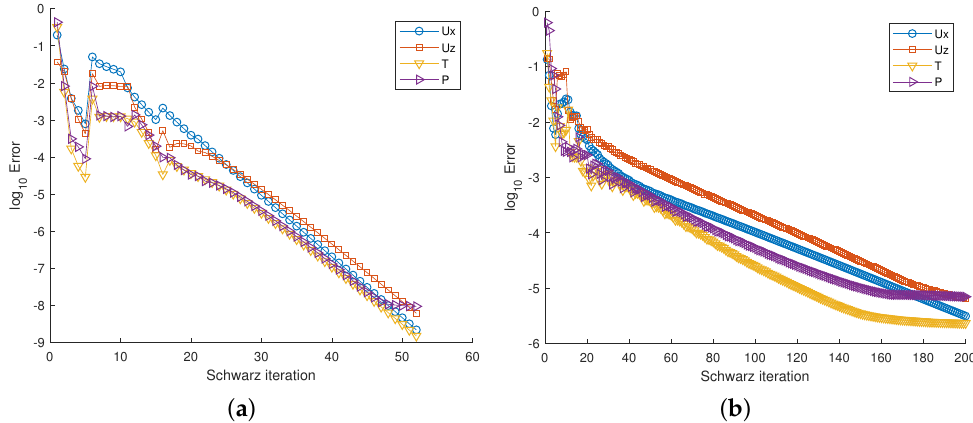
Figure 11. Graph of the log 10 of the errors in the velocity, temperature, and pressure fields for the Schwarz iterations: ( a ) R = 1300, Γ = 3.495, np = 2, mp = 1, N × M = 10 × 10; ( b ) R = 5000, Γ = 3.495, np = 8, mp = 2, N × M = 16 × 10.